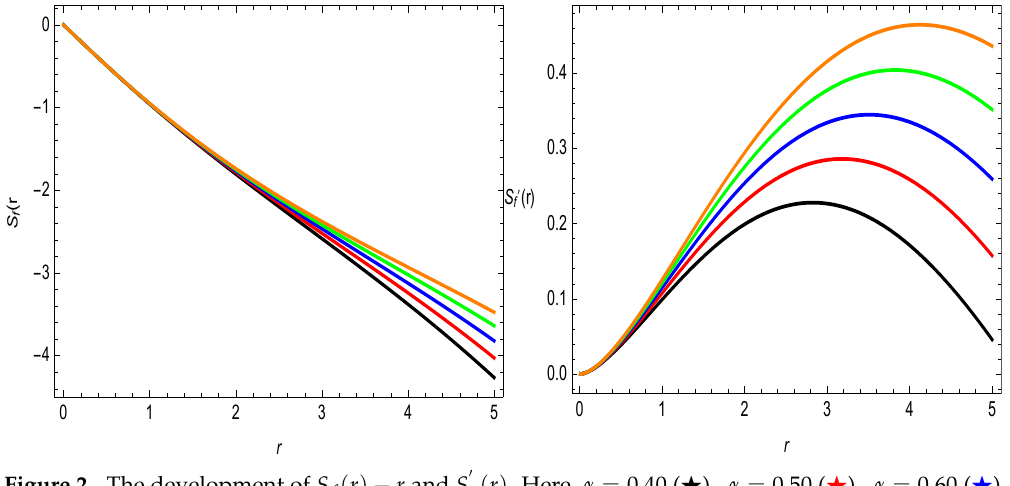
Figure 2. The development of S f ( r ) − r and S (cid:48) α = 0.70 ( (cid:70) ), α = 0.80 ( (cid:70) ), and γ = 0.10.